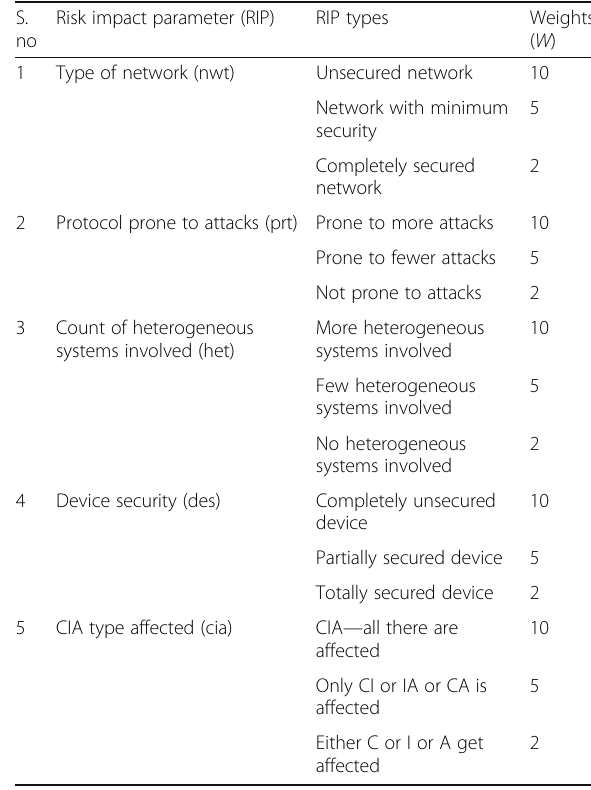
Table 6 Risk impact parameters with